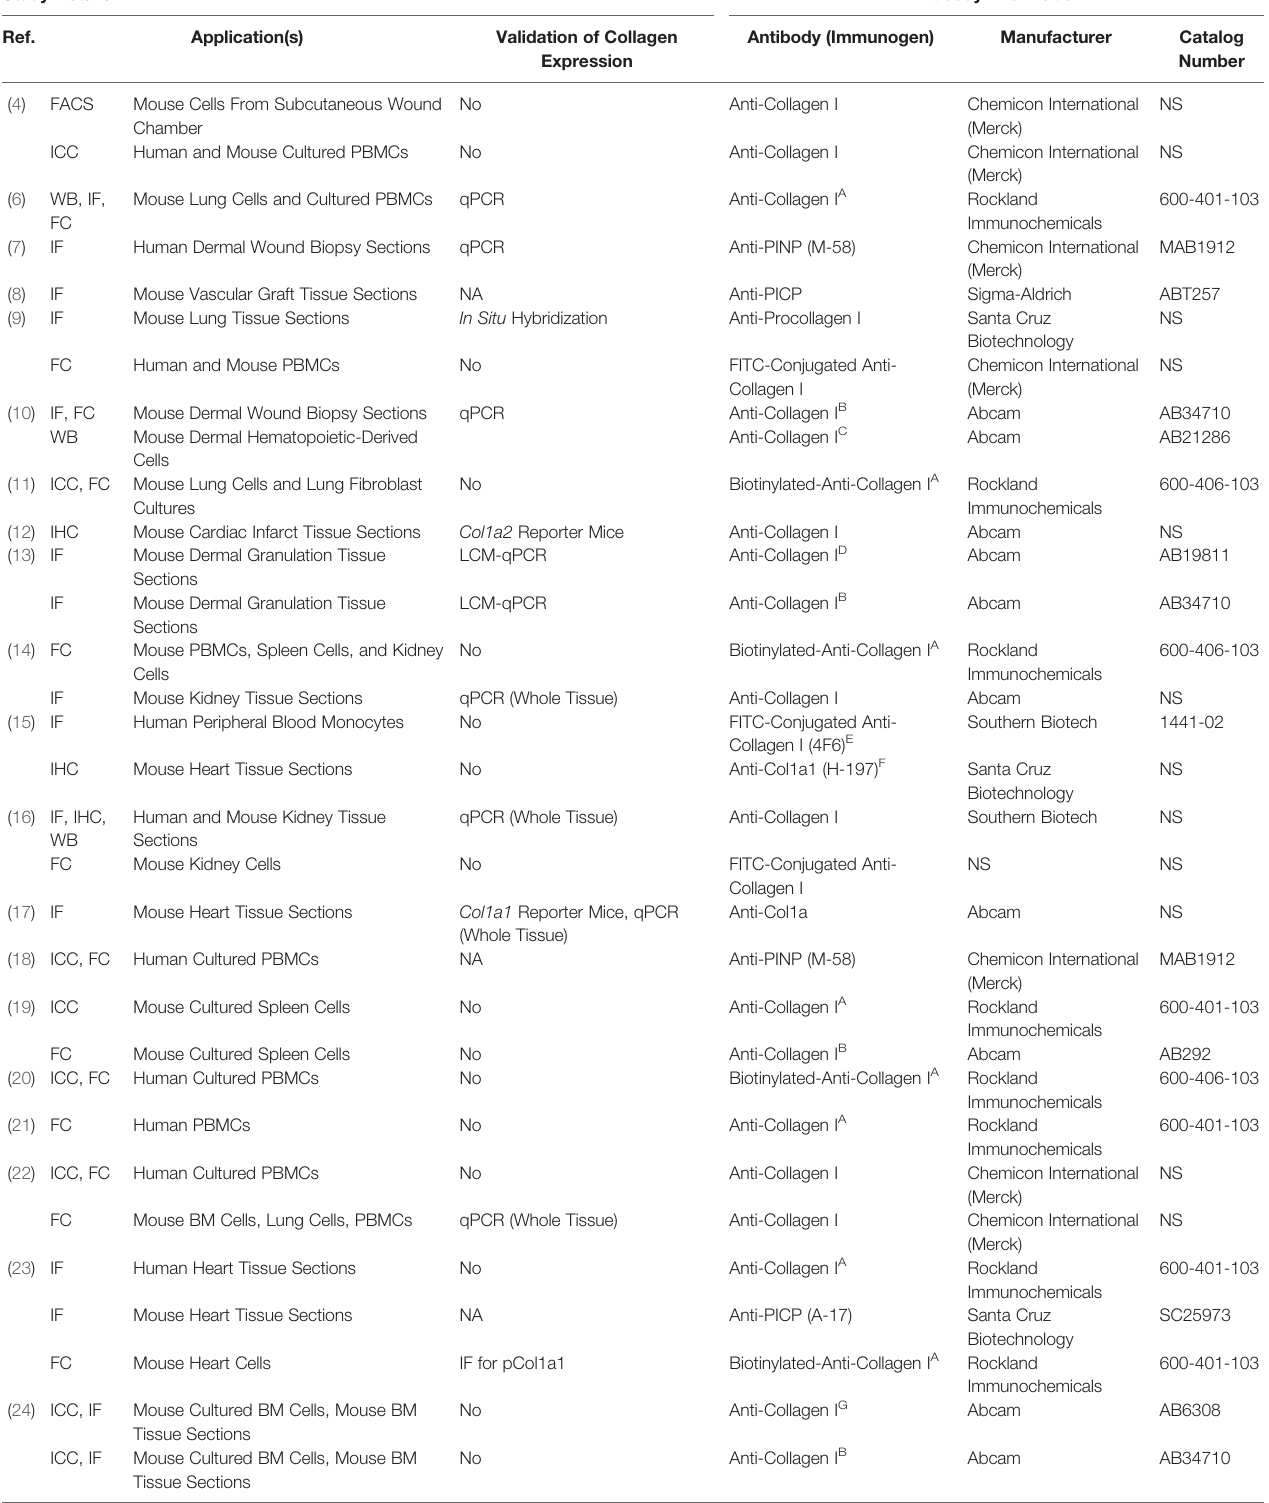
TABLE 1 | Anti-collagen